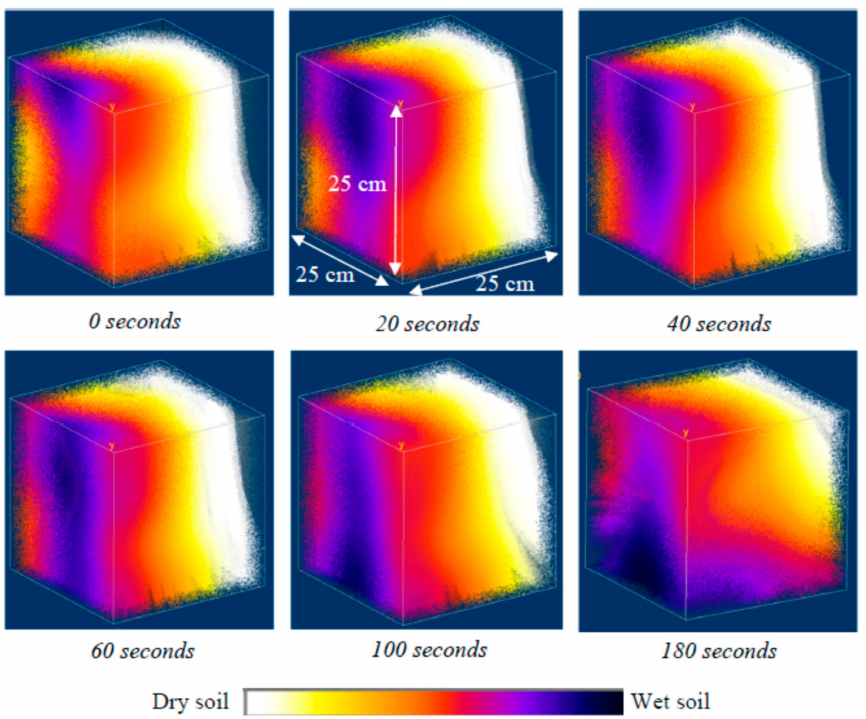
Figure 12. Three-dimensional visualization of relative moisture content. Water was applied at the top left corner (as shown in Figure 7). Six consecutive images show the dynamics of water over ~3 min period. The time passed since water application is shown below each